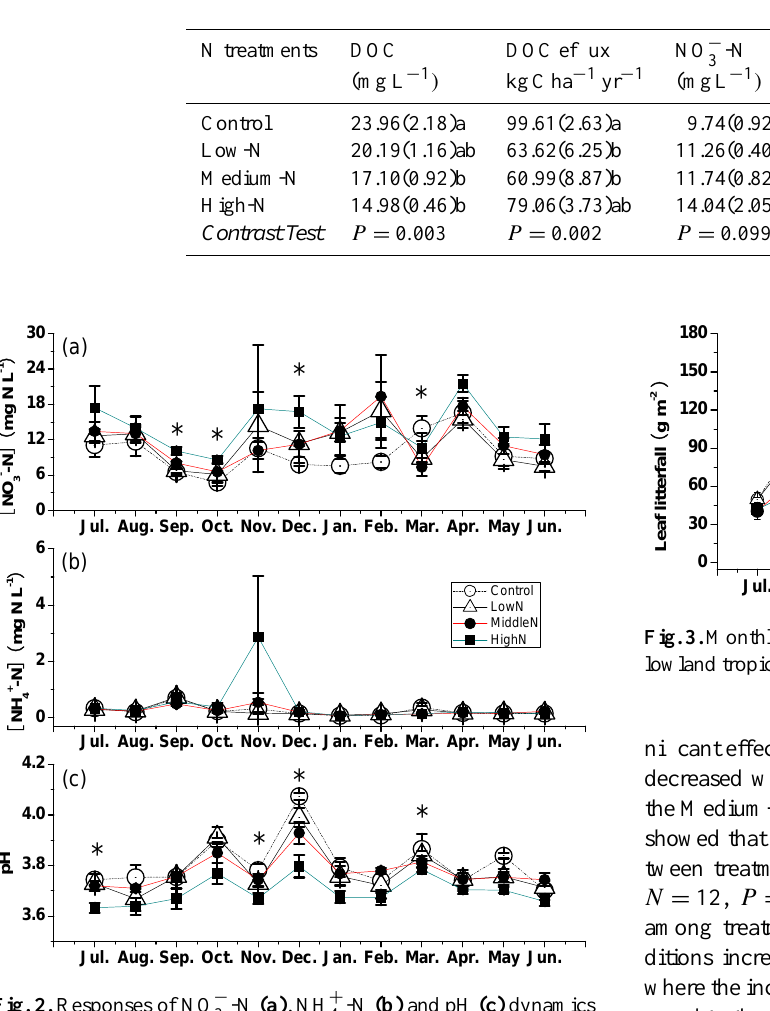
Fig. 2. Responses of NO − -N (a) , NH + -N (b) and pH (c) dynamics 3 4 to long-term N addition in soil solution below the dominant root- ing zone in the lowland tropical forests of Southern China. Asterisk ( ∗ ) indicates that there are significant differences at P < 0 . 05 level between N treatments and the Controls using planned contrast anal- ysis.